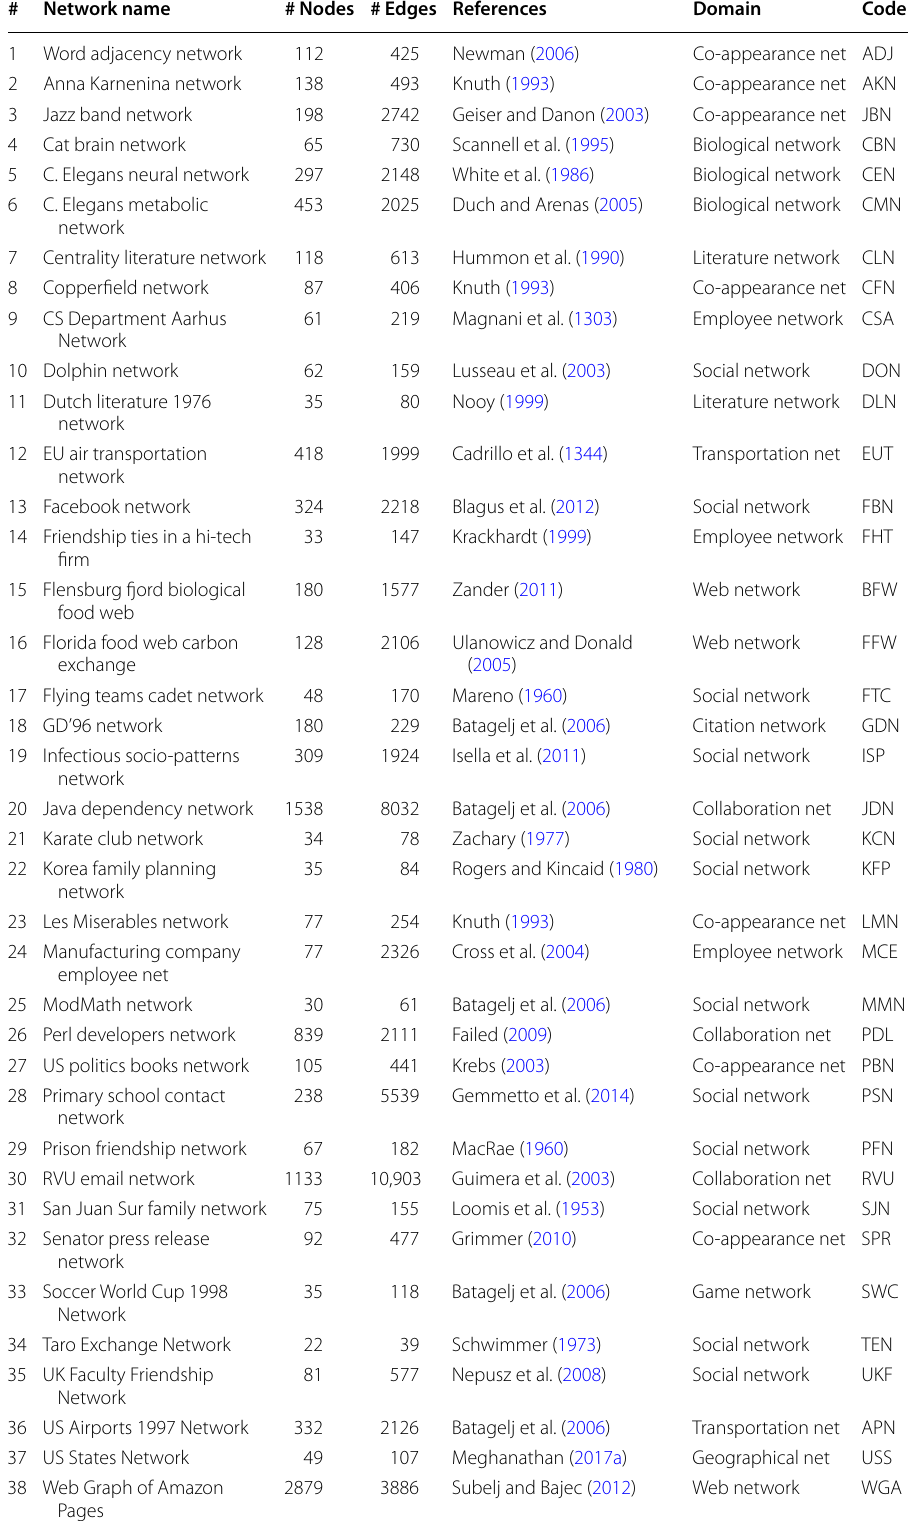
Table 2 Real‑world networks used for the